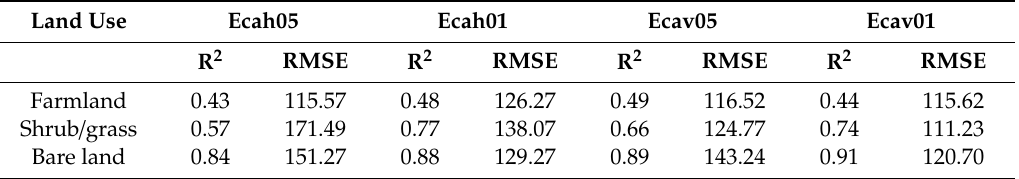
Figure 5. Scatter plots of measured vs predicted values for calibration model using four EMI coil configurations with 1:1 (green) and overall trend (red) lines. Table 5. Summary of the performance of ECa model in farmland, shrub / grass and bare land according to R 2 and